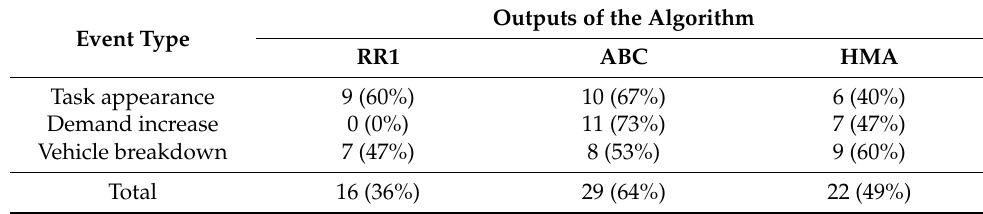
Table 11. The total number of the best outputs (and their percentage compared to the total number of outputs) of the algorithms RR1, ABC, and HMA summarized for the “egl-e1-A” instance, for each event